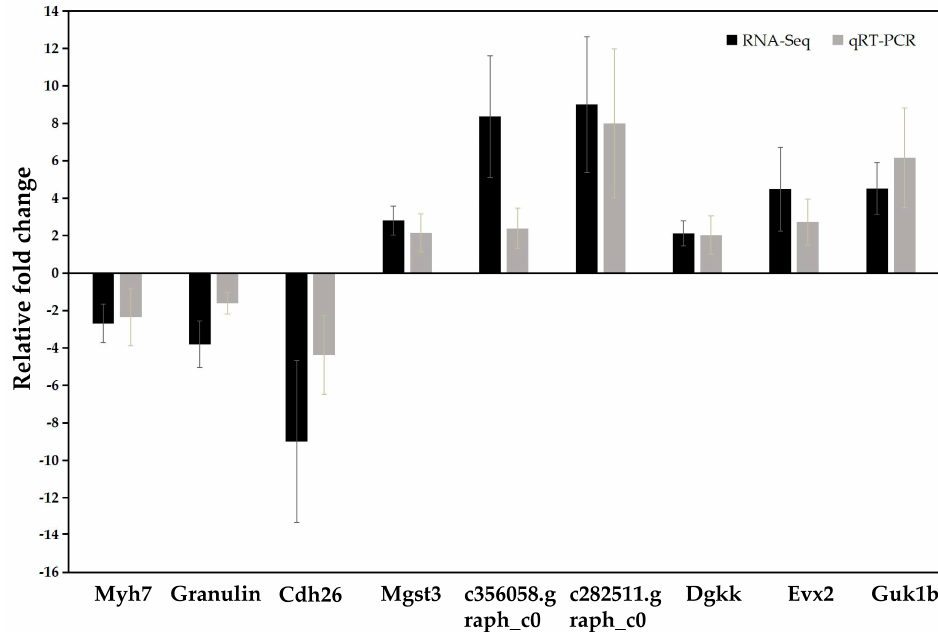
Figure 3. Illustration of qRT-PCR confirmation results for 9 randomly selected DEGs.